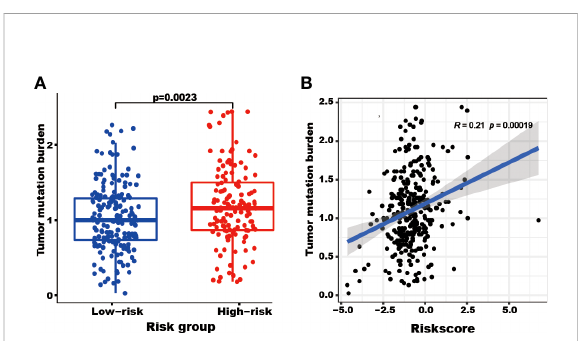
FIGURE 6 The tumor mutation burden (TMB) correlated with the TRGs risk score and groups. The TMB of patients in the high TRGs risk group (red points) was higher than those in the low TRGs group (blue points). (A) The patients ’ TMB positively correlated with TRGs risk score (p=0.00019). (B) .